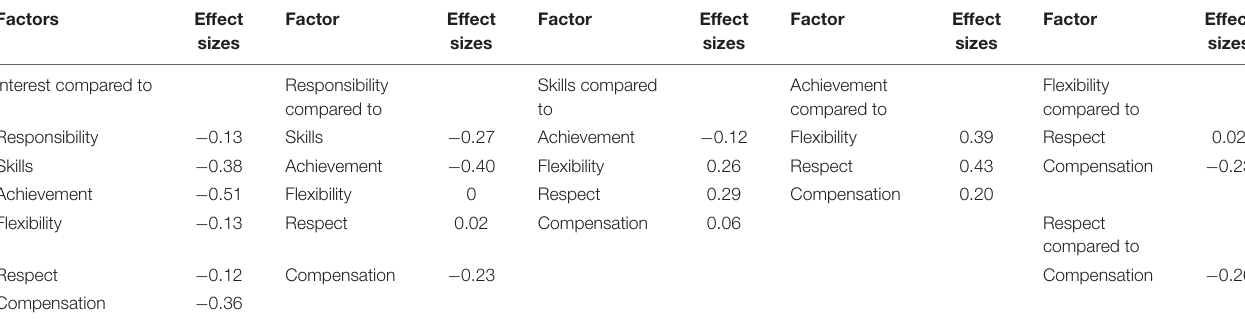
TABLE 12 | Effect sizes of the seven-factor research motivation.